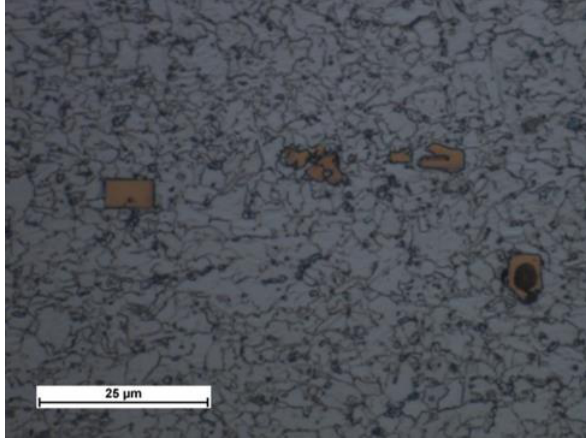
Figure 8. Clusters of characteristic sharp-shaped precipitates crystallised on impurity.